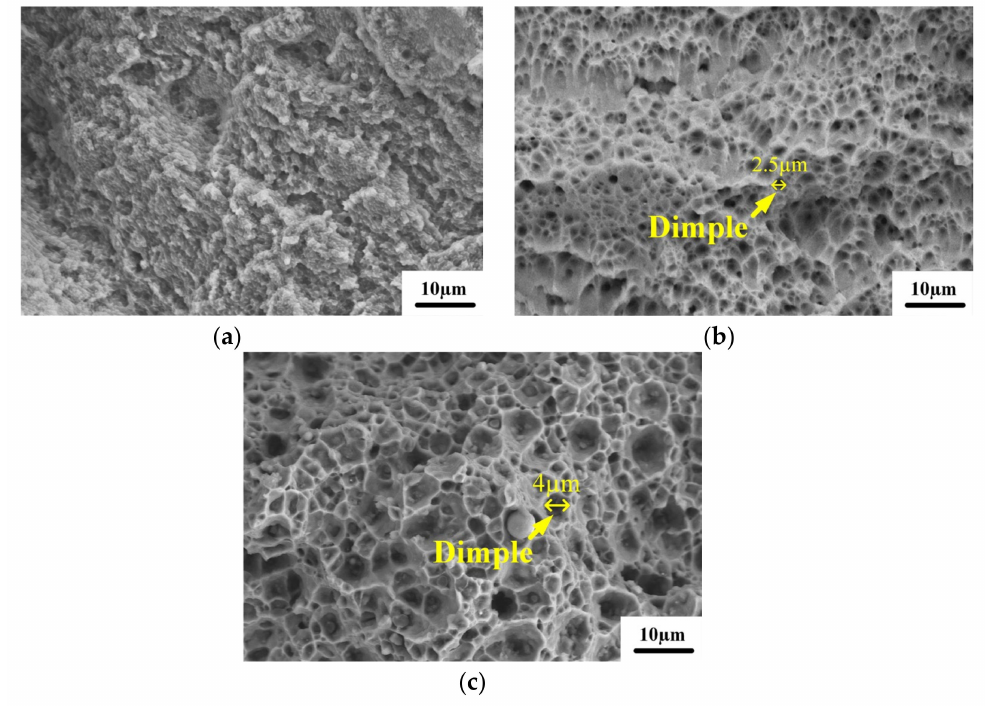
Figure 12. Microscopic morphology of tensile fracture under high magnification: ( a ) deposite; ( b ) 300 ◦ C /1 h; ( c ) 535 ◦ C /1 h + 175 ◦ C /2